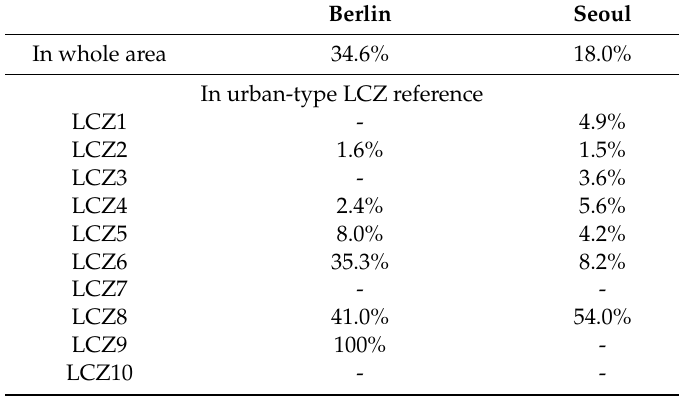
Table 2. Missing rates of height values in the entire study area and in urban-type LCZ reference data.